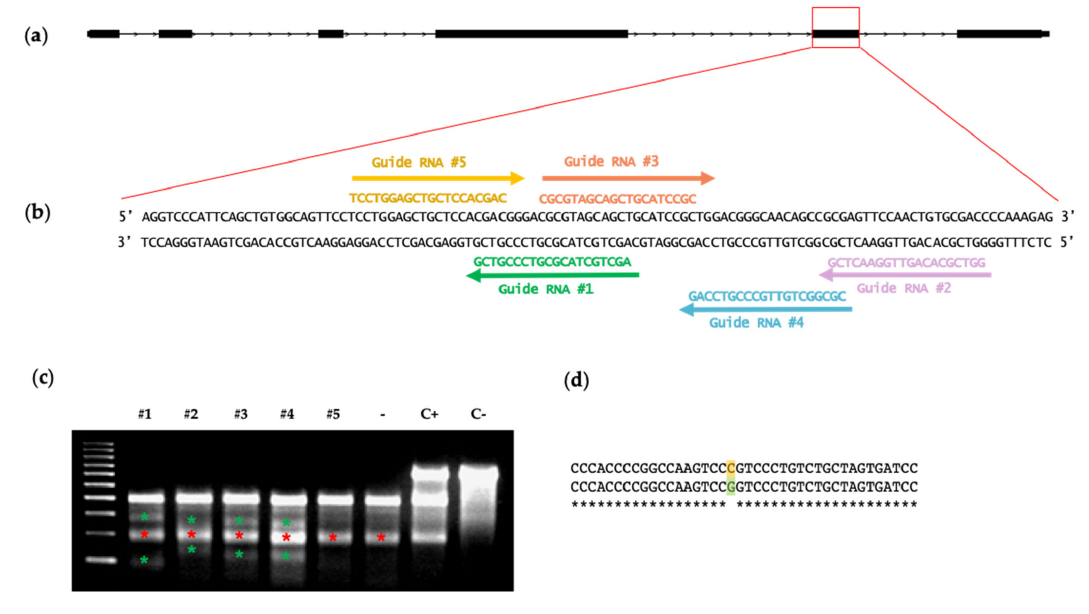
Figure 1. ( a ) Representation of the pig ETV2 gene structure; The ETS ‐ binding domain is encoded by exon 5 and 6. ( b ) The genomic target sequence and top five guides designed to target the ETV2 exon 5; ( c ) Analysis of the Surveyor digestion showing that guide RNAs #1 to #4 are functional in vitro while guide 5 did not mediate the Cas9 activity; specific bands are highlighted with green asterisks. One band at 200 bp that does not correspond to CRISPR/Cas9 gene editing is present in all pig fibroblast samples, including the negative control ( − ); red asterisks. C+: kit’s GC heterodimer and C − : CC homodimer are included as positive and negative control of Surveyor activity, respectively; ( d ) an SNP in the genomic DNA of porcine fibroblasts was discovered by comparing the sequences of 9 different PCR samples from control fibroblasts. The SNP (C/G) is shown with colors. Its position on ETV2 explains the 200-bp band produced by Surveyor